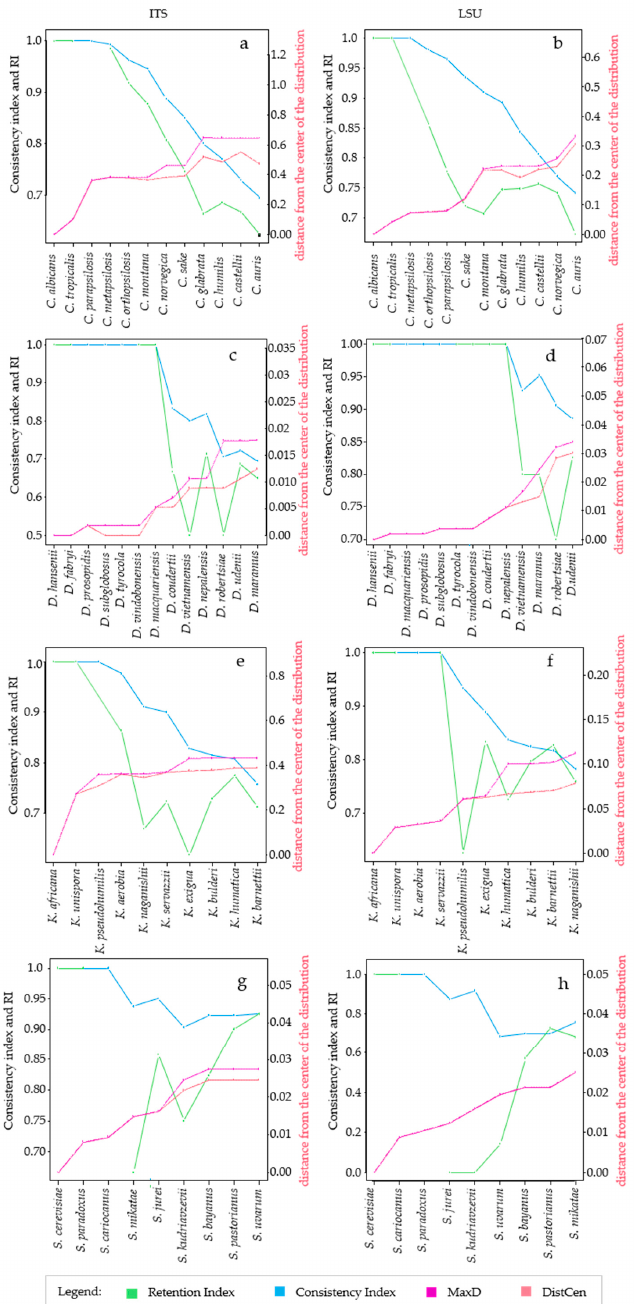
Figure 1. Variation of Homoplasy and phenetic Distances within different clades, at species level. The figure compares the trends of CI, RI and distances, taking into account one species at a time. Figure shows the trend of the metrics calculated for ITS , on the left, and LSU , panels on the right. The species considered for the analysis are reported in the x-axis, the leftmost species is the center of distribution. The left y-axis, in each plot, is a scale for Consistency and Retention Index and the secondary y-axis, on the right, is a scale for the distances. For every species added to the distribution, the algorithm calculates the following metrics: MaxD , in purple line, is the maximum distance obtained from the alignment of species. DisCen , in red line, is the distance of one species from the center of the series, which is represented by the first element in the X-axis. Consistency index (CI) , in blue line, is the ratio between the minimum number of changes it might show and the number of changes it does show on a particular tree. Retention index , represented with the green line, measures the fraction of apparent synapomorphy to actual synapomorphy. All these values were calculated starting from the alignment of ITS and LSU sequences of species within Candida clade, respectively ( a , b ); Debaryomyces clade, ( c , d ); Kazachstania clade, ( e , f ); Saccharomyes clade, ( g , h